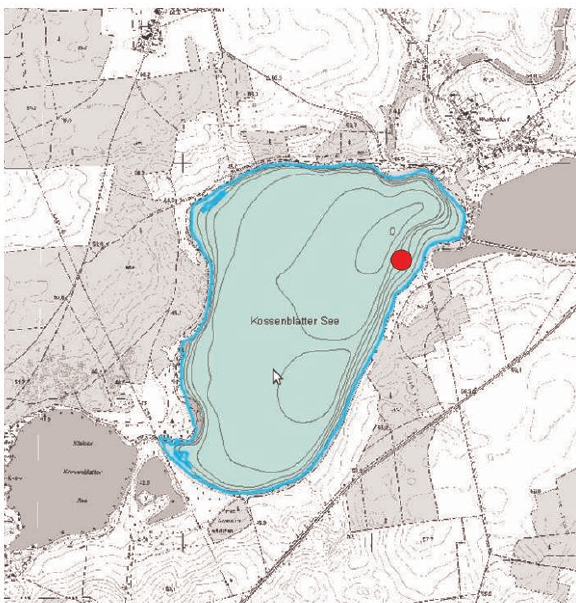
Fig. 1. Kossenblatter See and its neighborhoods. The lake has no major inlet; the only outlet is located in its southwestern section connecting it to Kleiner Kossenblatter See. The depth isopleths are drawn with 0.5m increments. The location of measurement mast is denoted by red circle. The map is adopted from the site of Mi- nistry of Environment, Health and Consumer Protection of the Fed- eral State of Brandenburg